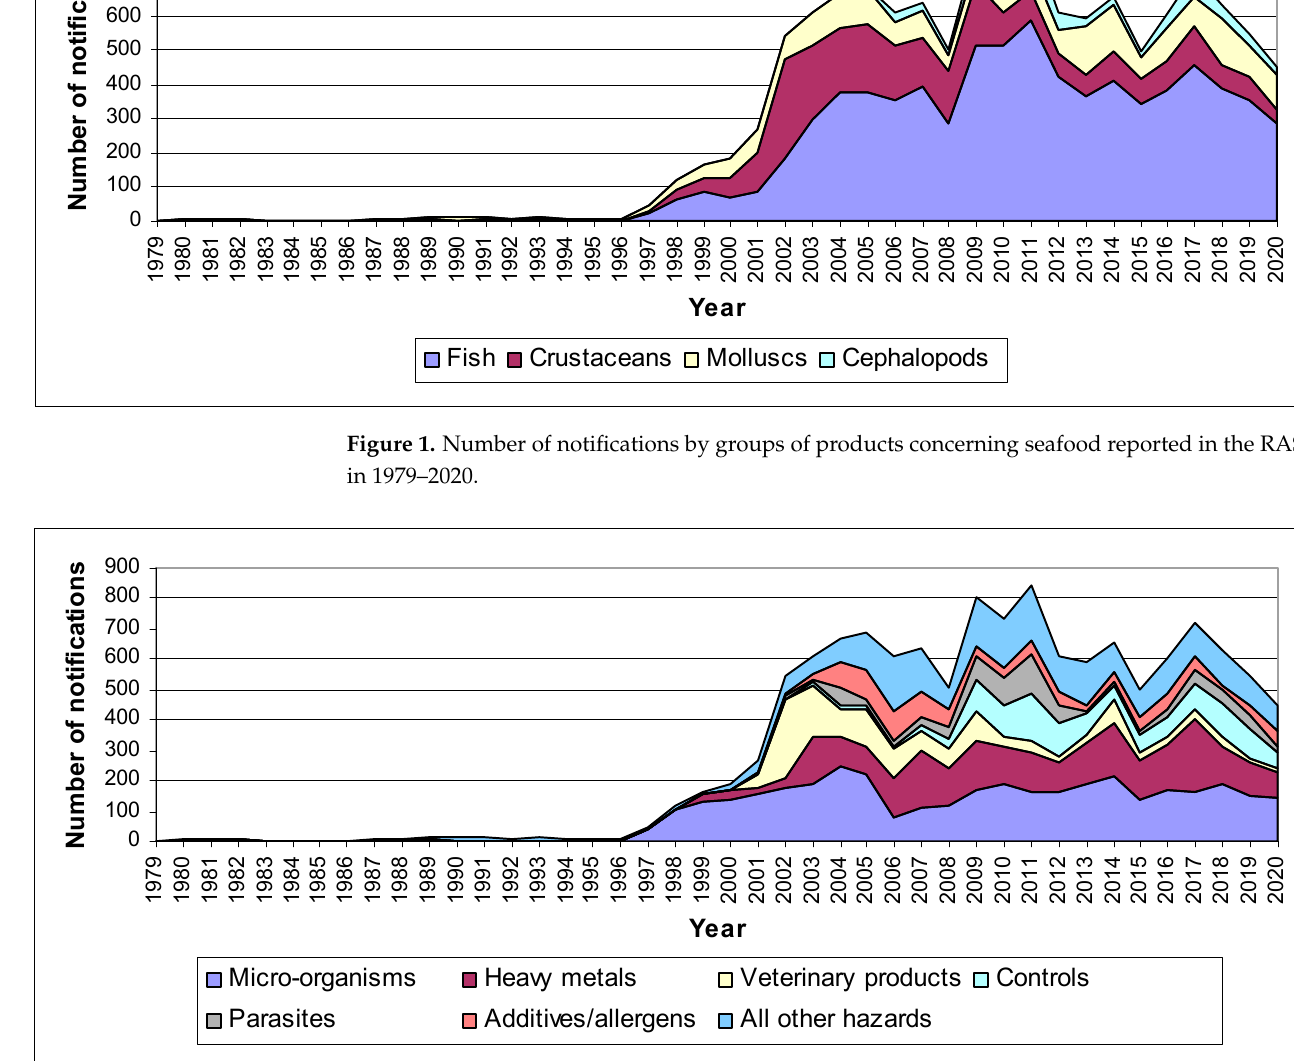
Figure 2. Number of notifications by groups of hazards concerning seafood reported in the RASFF in 1979–2020.